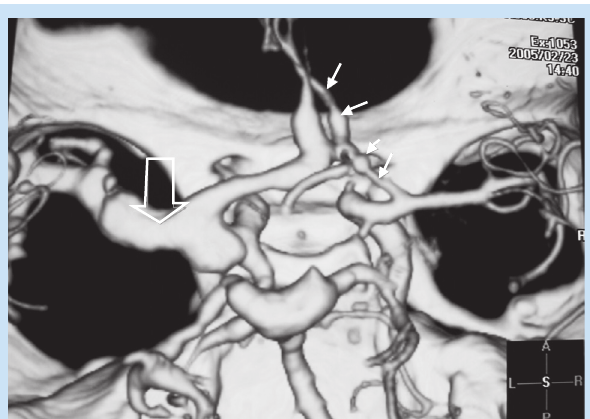
Fig. 6. Computed tomography angiogram (CTA) of the circle of Willis, showing vasculopathy with alternating areas of stenosis and dilatation of the proximal anterior cerebral artery (arrows) and middle cerebral artery (open arrow).